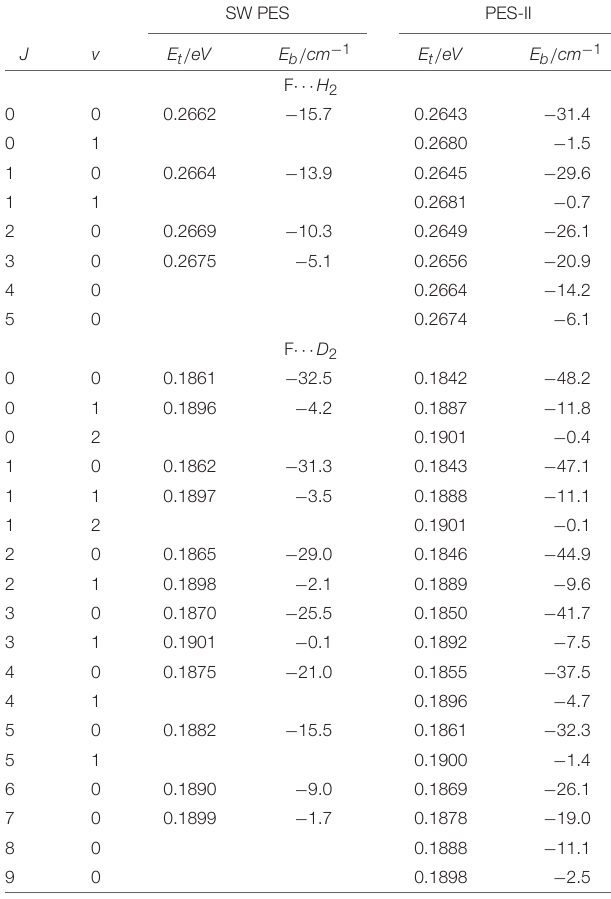
TABLE 1 | Roto-vibrational states of the three-atomic complexes F F D 2 supported by the entrance channel van der Waals well on SW PES and ··· PES-II.